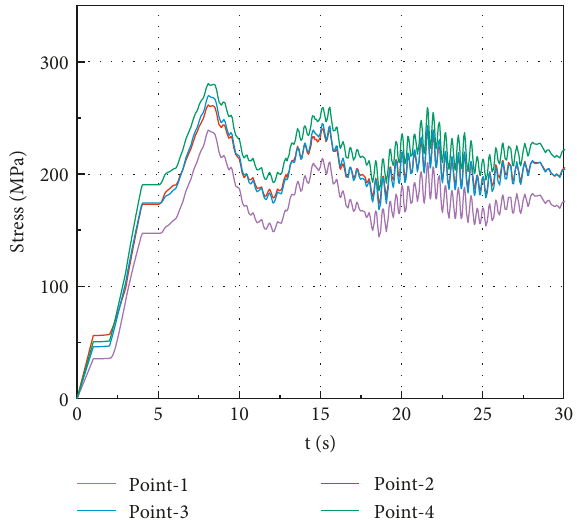
Figure 36: Stress-time curve of each